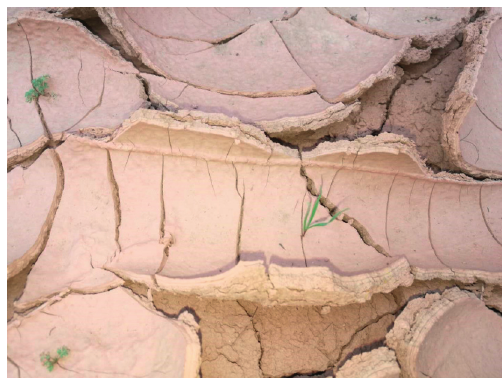
Figure 9: Curling of cracks observed in situ (Xi’an, Shaanxi province).